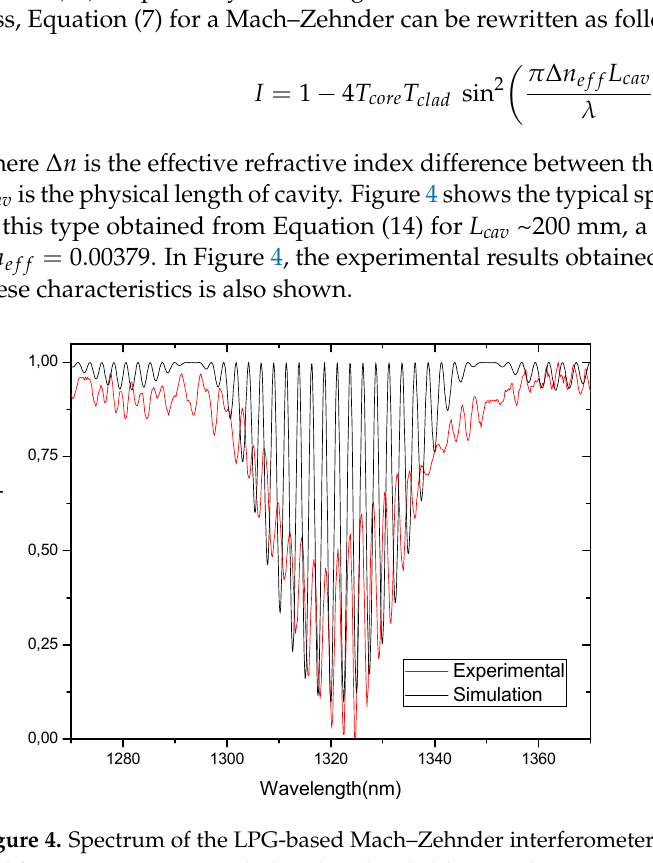
Figure 4. Spectrum of the LPG-based Mach–Zehnder interferometer for a cavity length of 200 mm and for LPGs operating with the 5th order cladding mode.